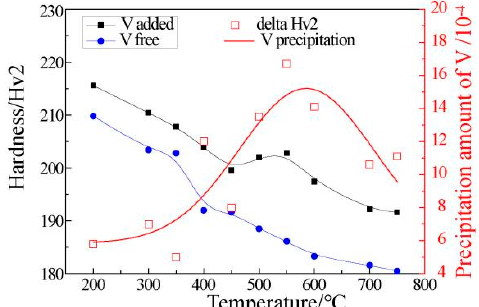
Figure 4. Relationship between precipitation amount of V and tempering